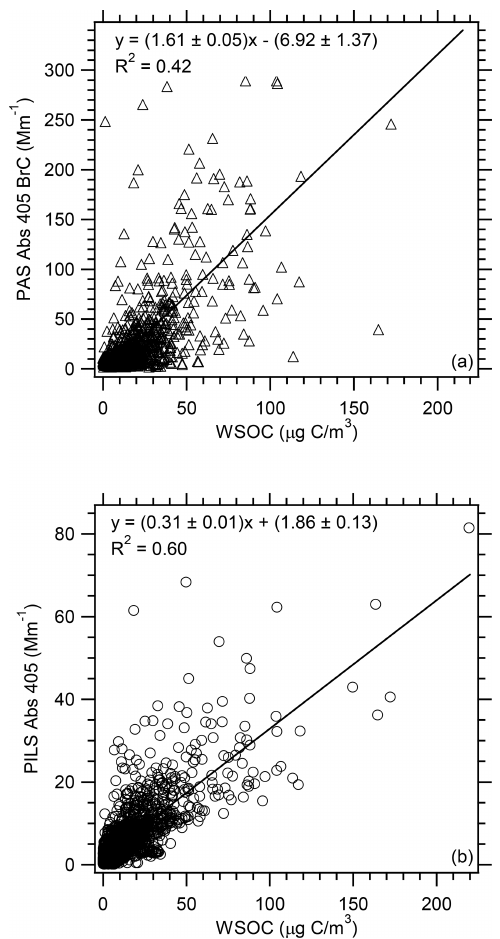
Figure 6. Correlation of (a) PAS total Abs 405 BrC and (b) PILS water-soluble Abs 405 vs. CO for all WE-CAN flights used in this analysis. Uncertainties with the least square regressions are 1 stan- dard deviation.